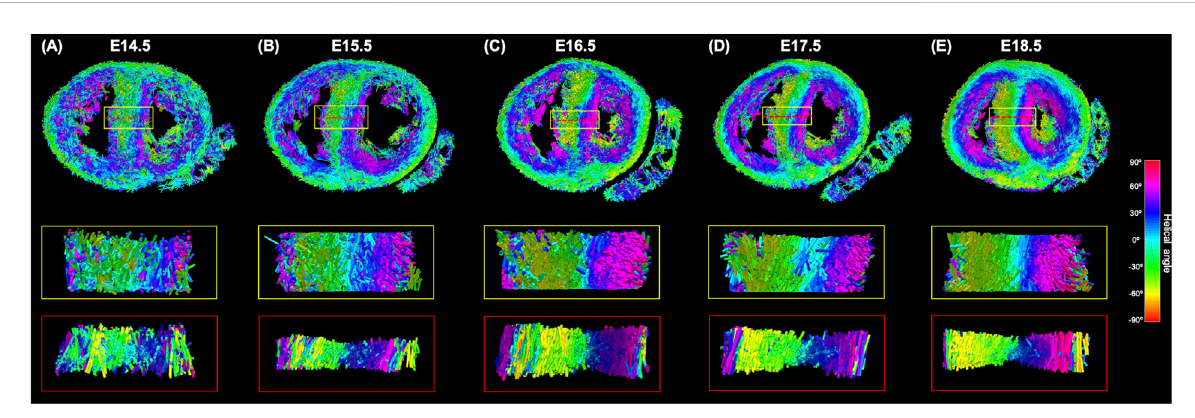
FIGURE 8 Three-dimensional representation of the tertiary eigenvector representing the longitudinal direction of aggregated myocytes for a single mid- LVsliceofthedevelopingmurineheartat (A) E14.5, (B) E15.5, (C) E16.5, (D) E17.5and (E) E18.5daysofgestation.Theinsetsrepresentmagni fi edareas within the septum, illustrating well how cardiomyocytes show different angles of intrusion throughout the septal wall, and how the myocardium becomes more organised with gestational